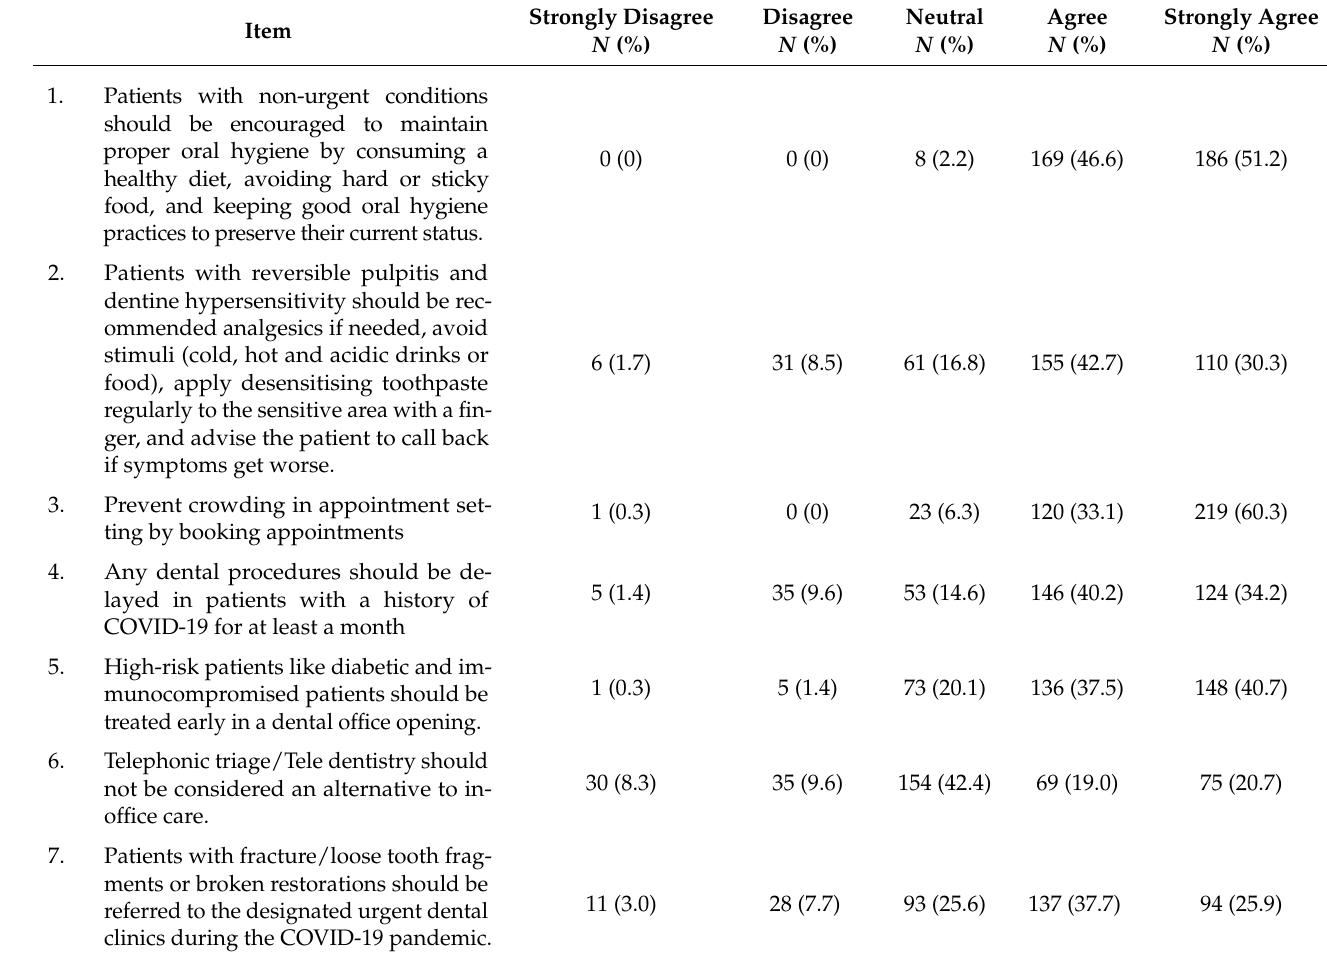
Table 2. Frequency and percentage of participants’ responses to each